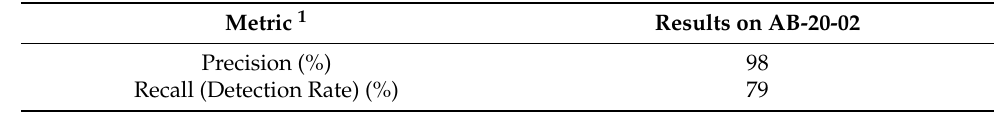
Table 1. Result validity